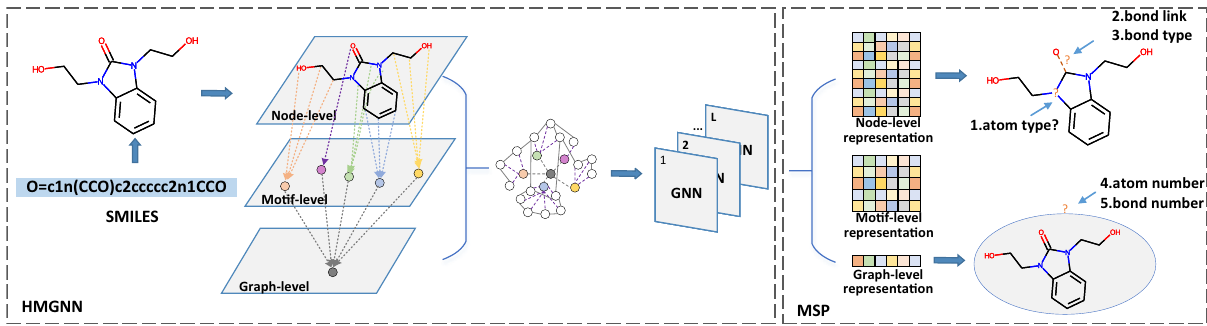
Fig. 1 Illustration of HiMol. HMGNN: the input molecular graph is fi rst decomposed into motifs, which are constructed as motif-level nodes. Further, a graph-level node is added. The augmented graph is constructed by adding node-motif and motif-graph edges. GNN is employed to learn hierarchical node representations on the augmented graph. MSP: encoded atom representations and molecular graph representation predict fi ve tasks for self-supervised